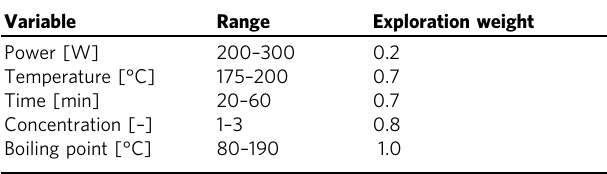
Table 1 Experimental variables investigated in this study.